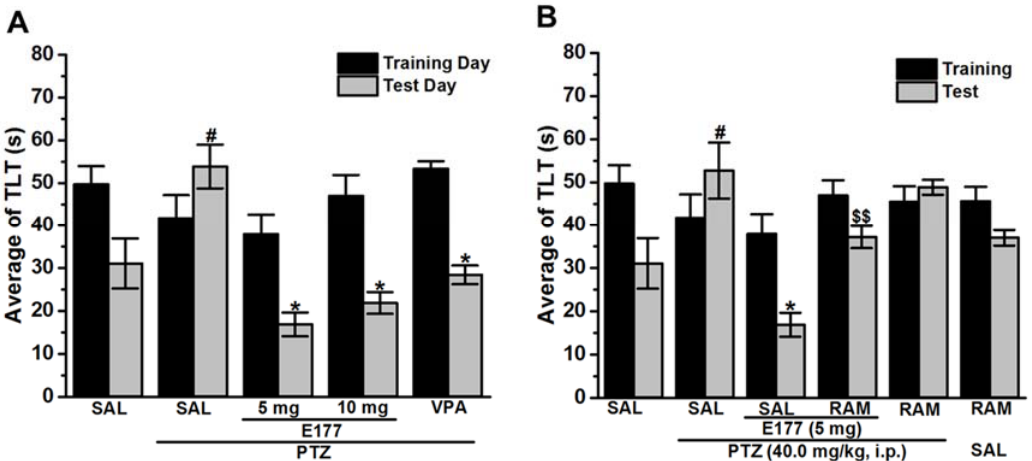
Figure 3. H3R antagonist E177 treatment attenuated PTZ-induced memory deficits in elevated plus maze test. Average of TLT measured on the first training day, namely 24 h after last PTZ injection (black columns), and average of TLT measured on the test day, namely 24 h after the training day (gray columns). ( A ) # P < 0.05 vs. saline-treated group. * P < 0.05 vs. PTZ-kindled group. ( B ). $ P < 0.05 for average STLs compared with the H3R antagonist E177 (5 mg)-treated rats. $$ P < 0.001 for average STLs compared with the H3R antagonist E177 (5 mg)-treated rats. Values are expressed as the mean + SEM ( n = 6).